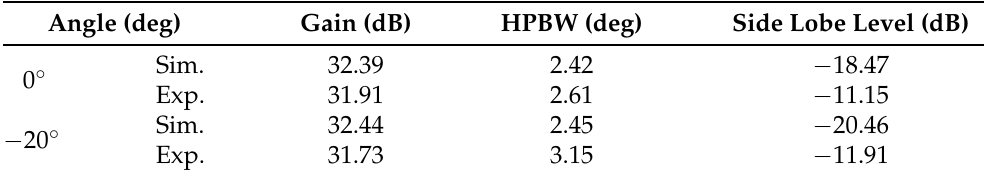
Table 1. Measured and simulated radiation performances of two-bit digitized reconfigurable metal reflectarray antennas in the